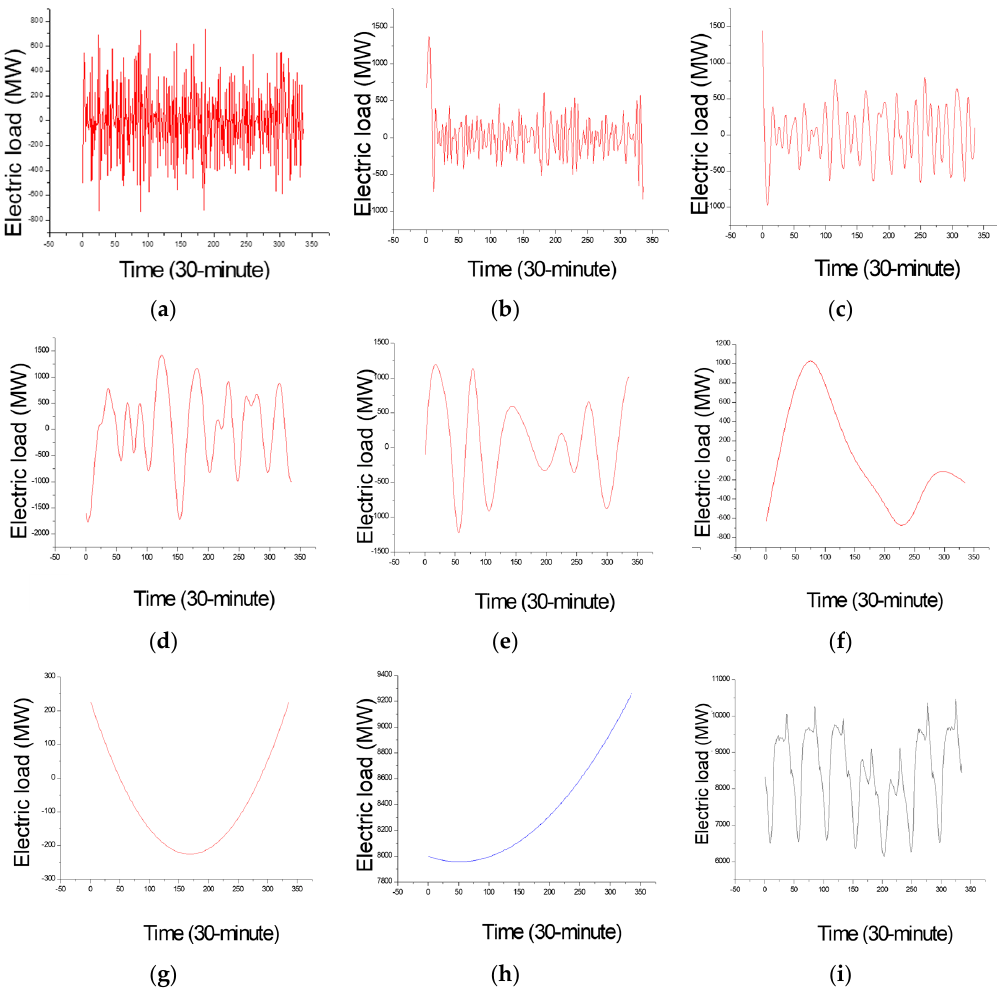
Figure 6. The decomposed different items for small data size (Example 1). ( a ) IMF (intrinsic modulo function) 1; ( b ) IMF 2; ( c ) IMF 3; ( d ) IMF 4; ( e ) IMF 5; ( f ) IMF 6; ( g ) IMF 7; ( h ) residuals; ( i ) the raw data.